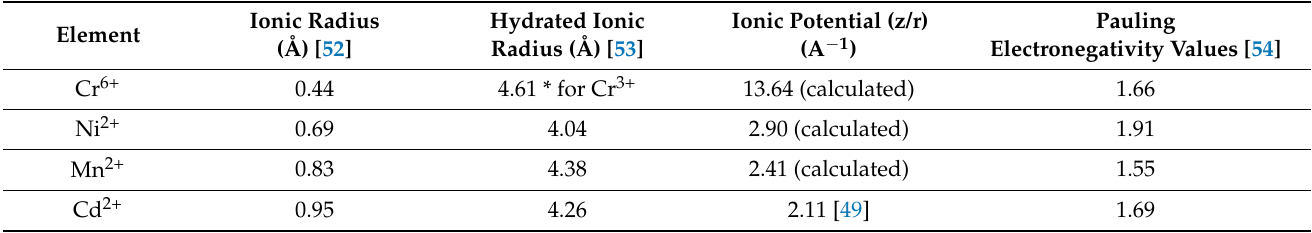
Table 2. Ion characteristics of the tested heavy metals.